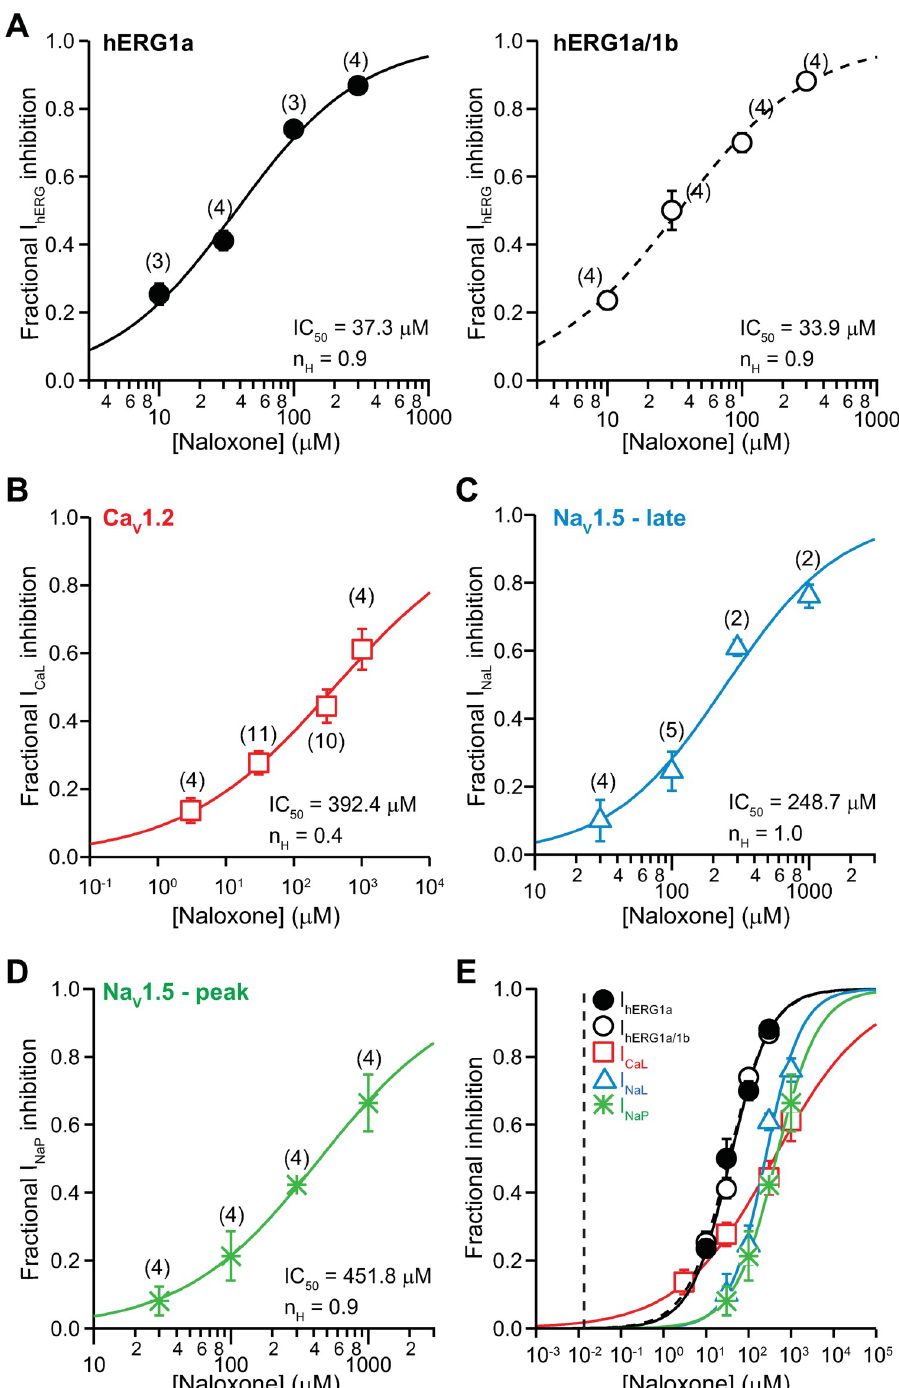
Fig 7. Effects of naloxone. Concentration-inhibition plots of naloxone on I hERG (A) , I CaL (B) , I NaL (C) , and I NaP (D) . E) An overlay of concentration-inhibition curves for all studied currents. The vertical dashed line indicates free C max of 0.013 μ